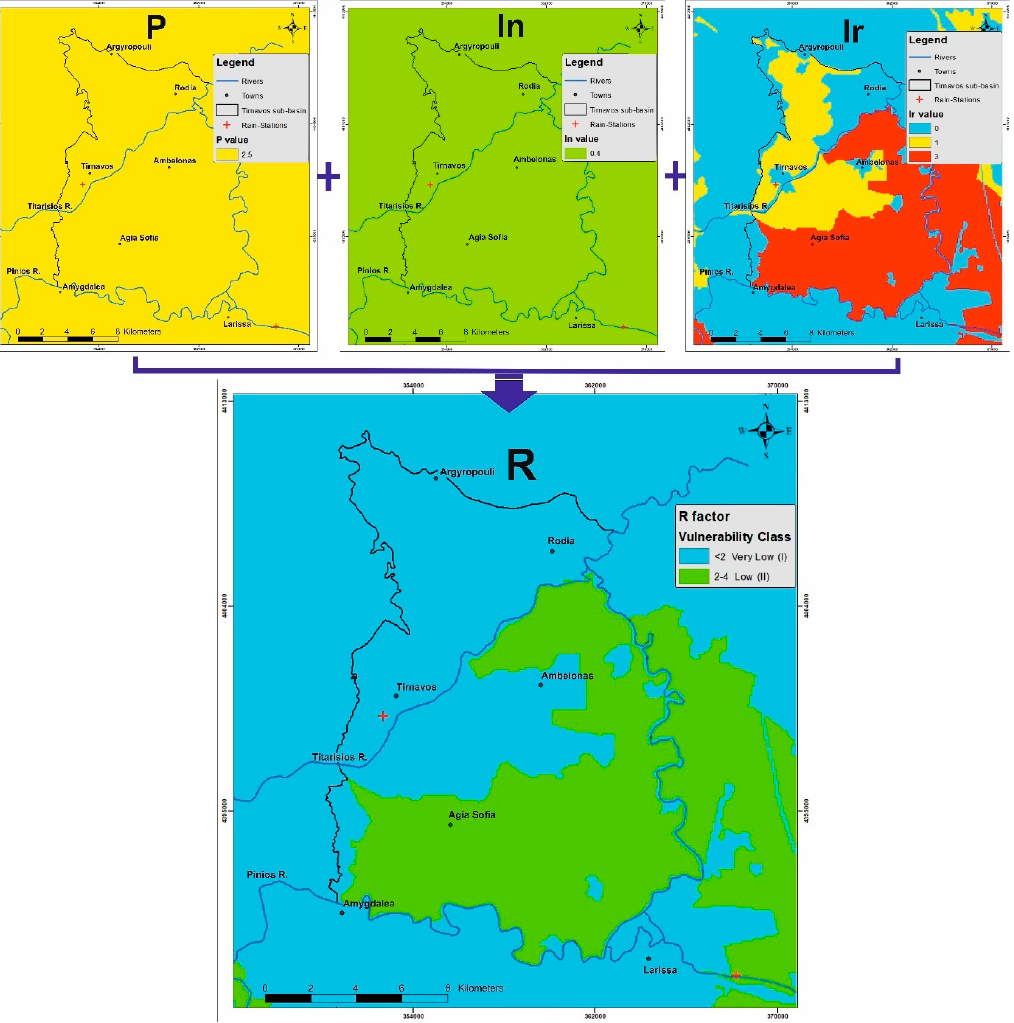
Figure 5. Spatial distribution maps of P, In, and Ir sub-factors in the Tirnavos basin and the R factor map compiled as a synthesis of the sub-factors above.